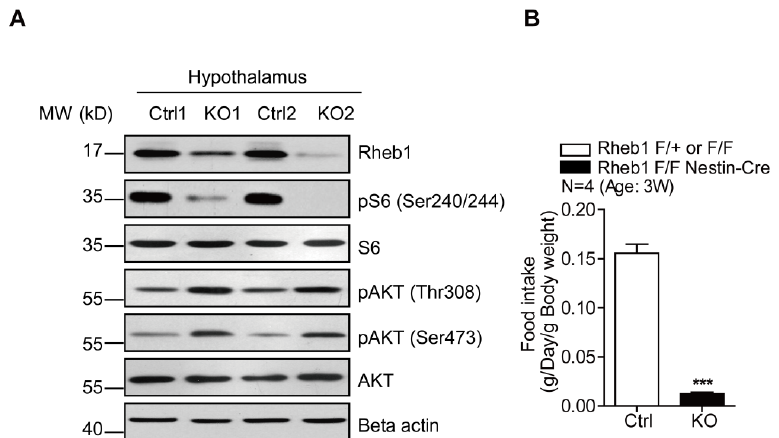
Figure 1. Genetic deletion of Rheb1 in the brain disrupts food intake. ( A ) Western blotting showing that Rheb1 and pS6 (Ser240/244) protein levels are reduced in Rheb1 ko hypothalamus; ( B ) Histograms showing the drastic reduction of food intake in Rheb1 ko mice compared to controls ( N = 4). Results are averages of four independent animals. Data represent mean ± SEM. *** p <